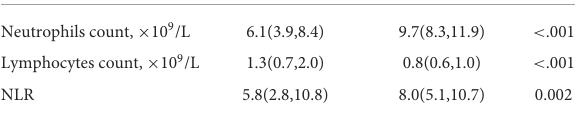
TABLE 2 Wilcoxon test results of neutrophil count, lymphocyte count, and neutrophil–lymphocyte ratio (NLR) before and after operation immediately.